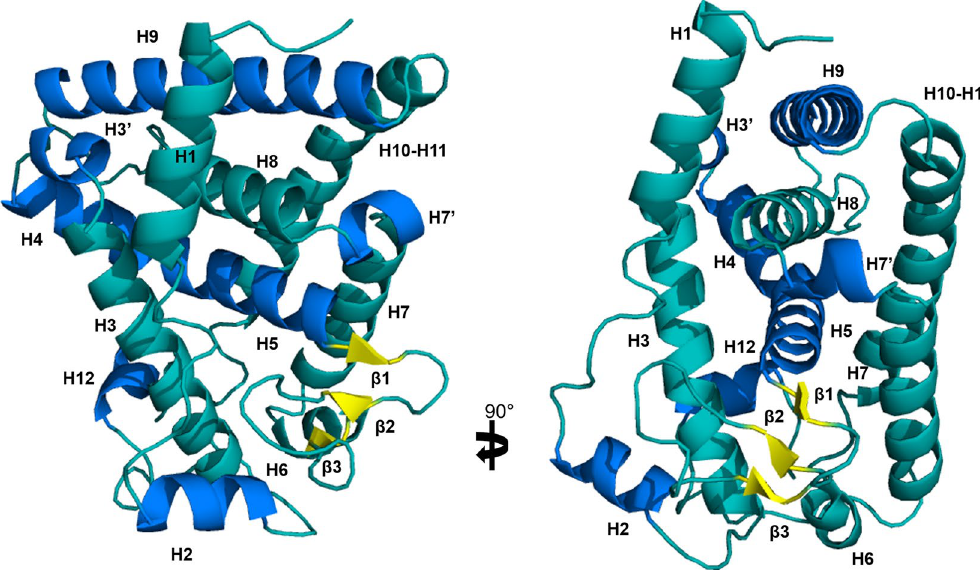
Figure 3. Structure of DimDAF-12 ligand binding domain model. The model of DimDAF-12_LBD (A and B) was constructed using Modeller and the coordinates of the crystal from Ancylostoma ceylanicum DAF-12 (pdb:3up0) and Strongyloides stercoralis DAF-12 (3gyt). Similar to the other members of the nuclear receptor family, DimDAF-12 exhibits 13 helices and three β-strands, which are packed in a three-layer α-helical sandwich to create a ligand binding pocket, where the DAs were found to bind in the case of AceDAF-12 and SstDAF-12. α-helices were either shown in teal or marine to distinguish them, β-strands were colored in yellow and the loops in teal. All images were generated using PyMol 1.3 (https ://pymol